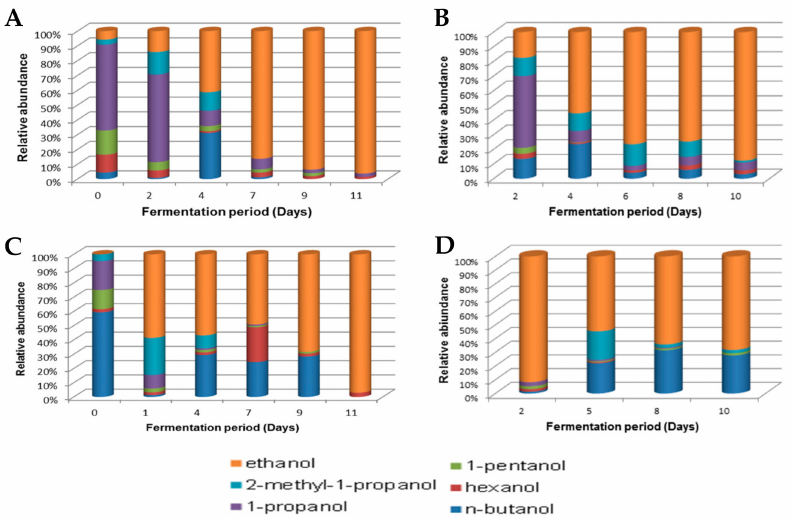
Figure 6. Alcohols during fermentation of the marula wines from Lab ( A ), Mentz ( B ), Moshira-A ( C ) and Moshira-B ( D ).